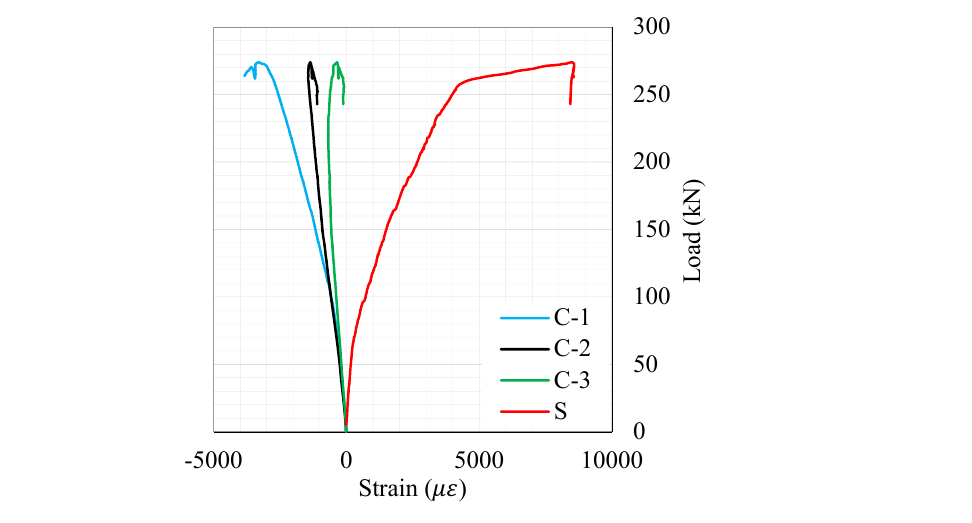
Figure 11. Load vs. strain responses of the B2 UHPC beam.